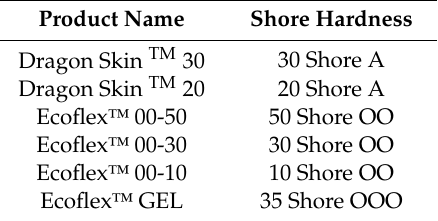
Figure 4. Experimental setup for sensor calibration. Table 2. Specifications of silicone.